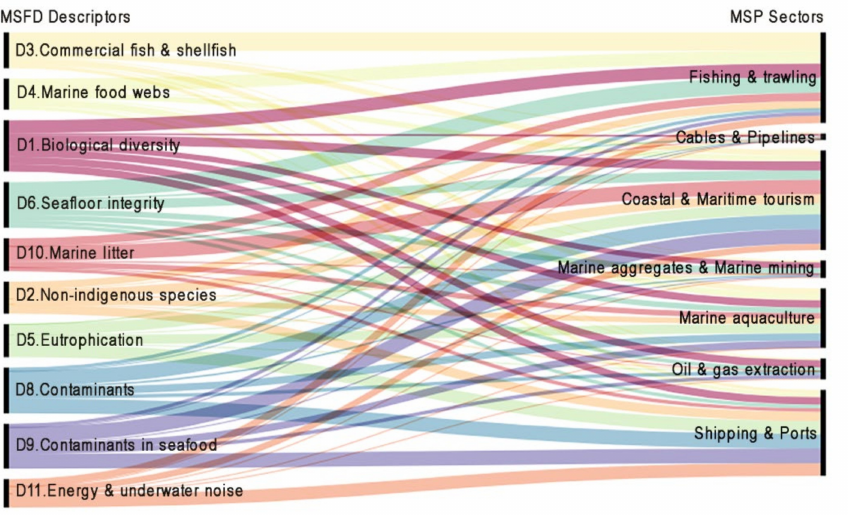
Figure 4. The interrelations between MSFD descriptors and MSP sectors in the Greek